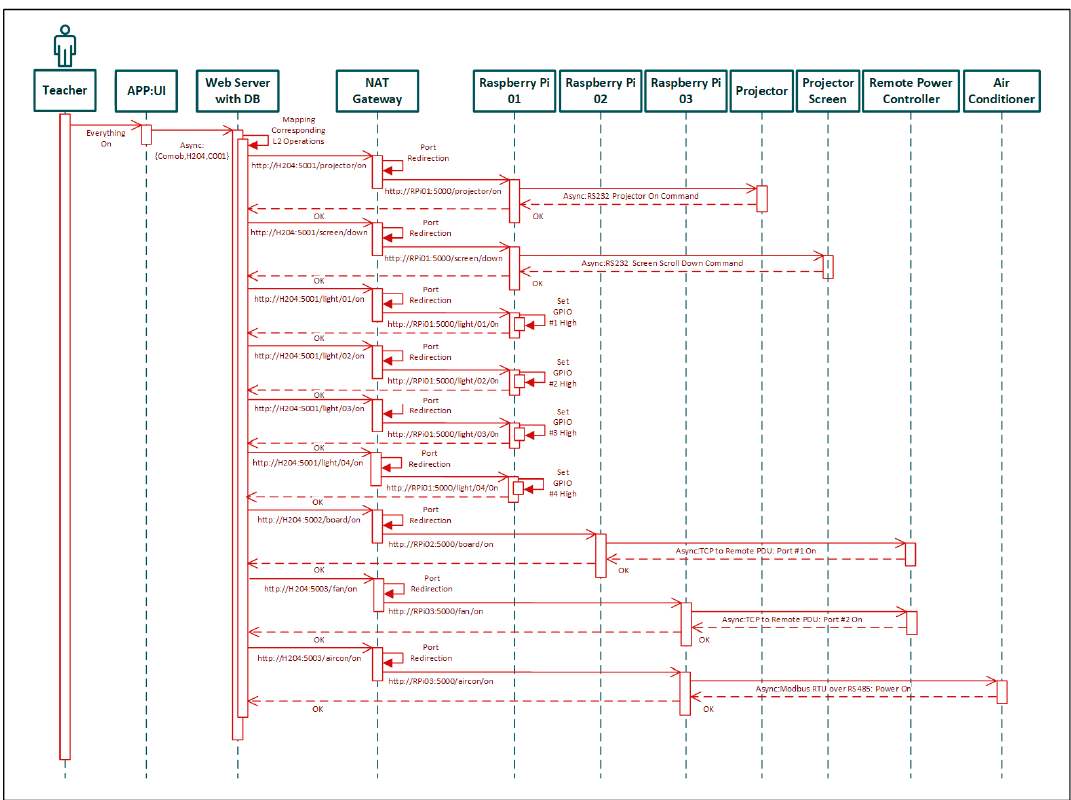
Figure 11. Sequence diagram of the operation described in Figure 10.